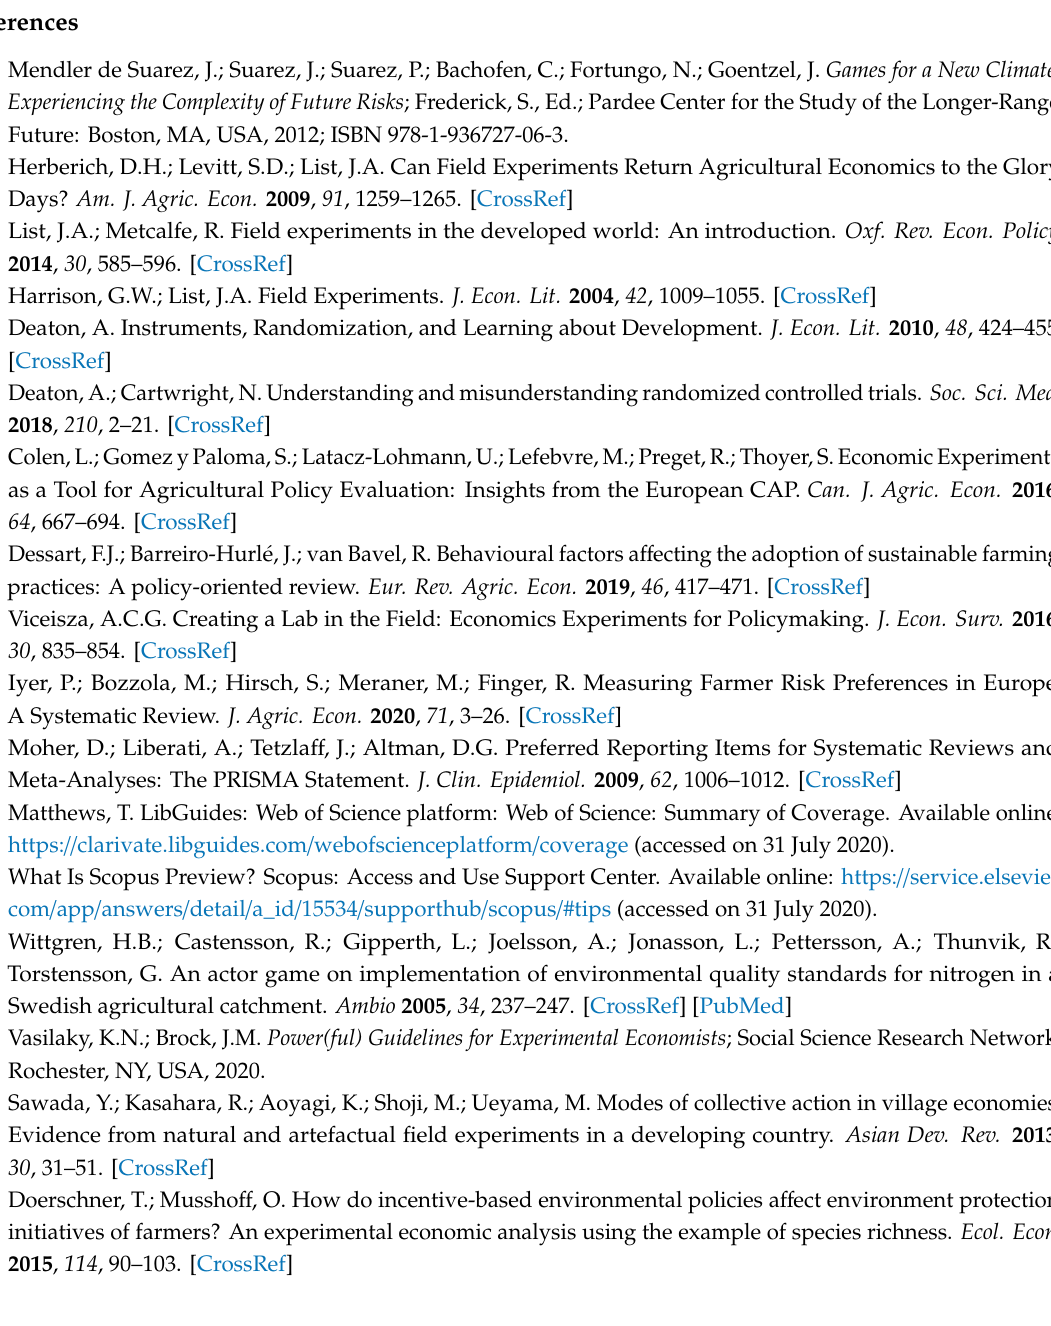
Figure A4. Frequency of studies by subject (individuals, groups, both) over